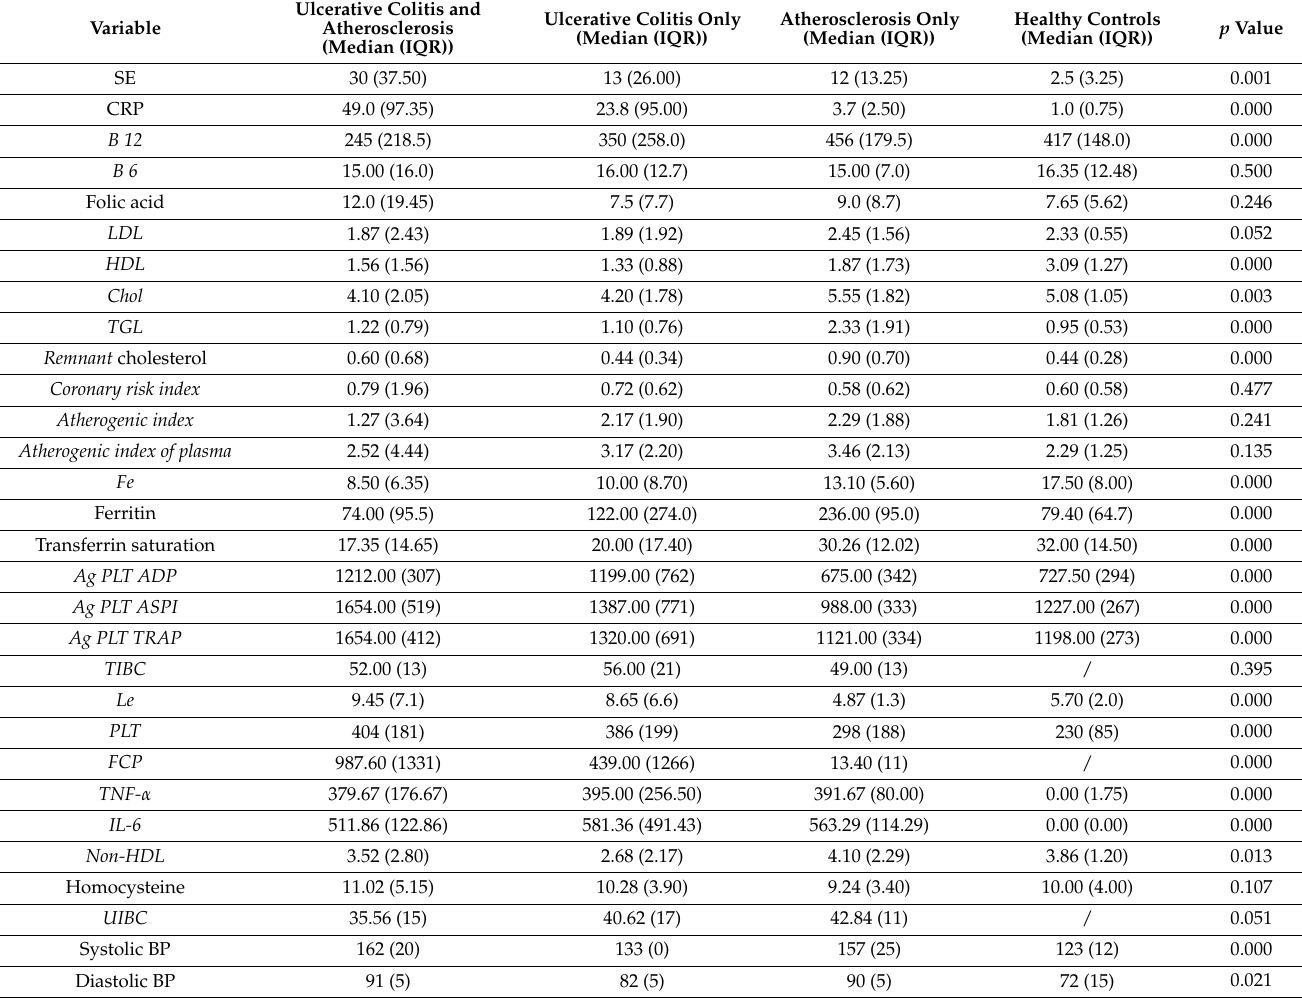
Table 1. The difference in patient parameters between the four study